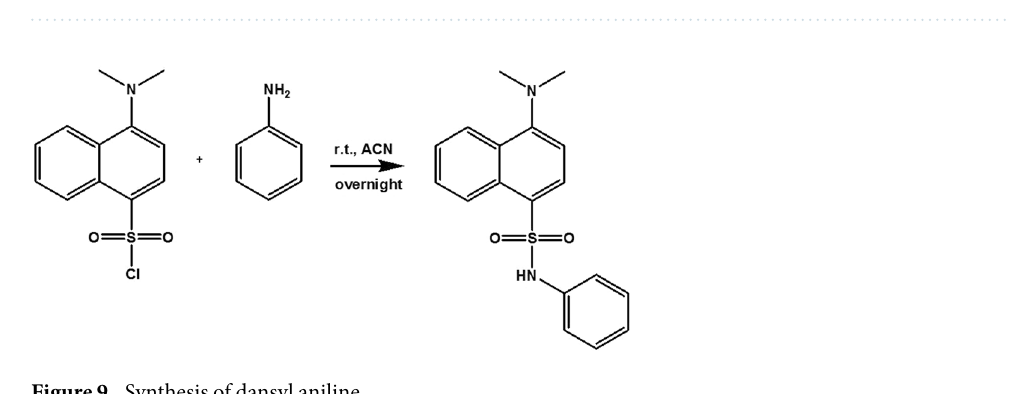
Figure 8. Synthesis of furo[3,2-c]coumarin derivatives.